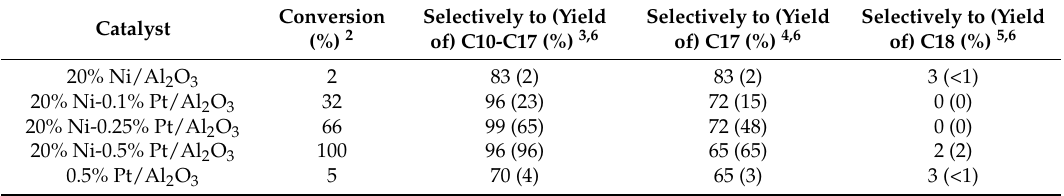
Table 3. Semi-batch deoxygenation of tristearin (580 psi of H 2 , 260 ◦ C, 3 h reaction time) 1 .